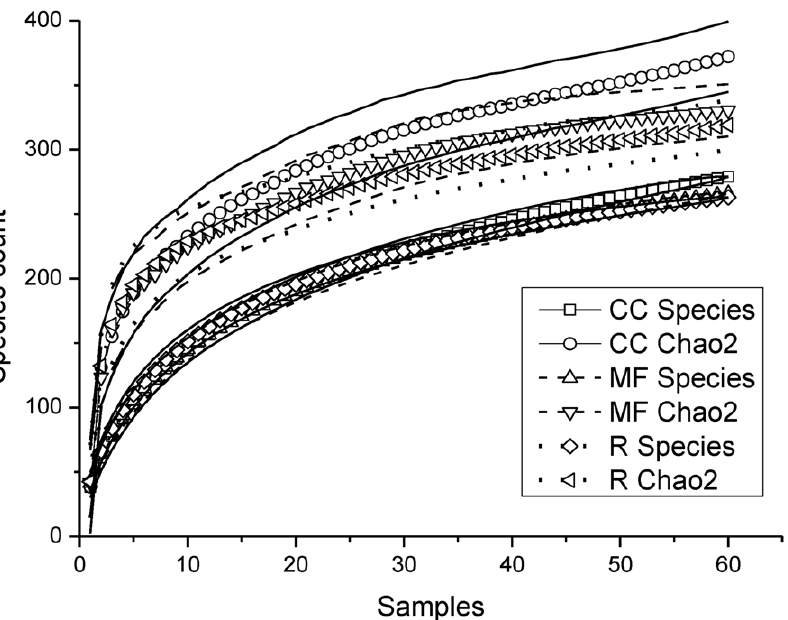
Figure 3. Rarefaction curves. Sample-based rarefaction curves estimates for both total species richness, including species not present in any sample (chao2) and based on all species actually discovered (Sobs) for each forest type. Error curves shows 6 1 SD